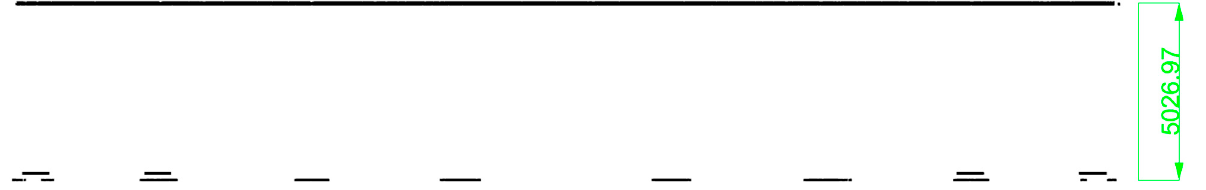
Figure 20. The column height.